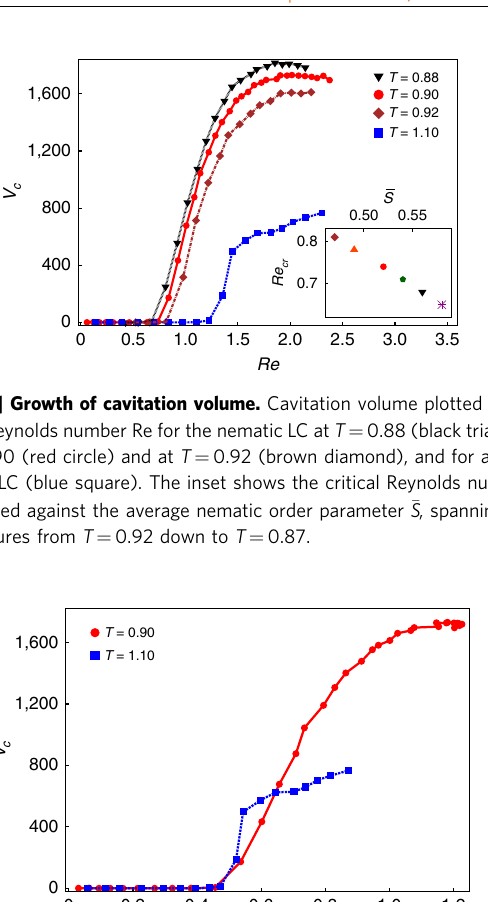
Figure 3g–i maps the local velocity over the mid-plane cross section ( x - y plane) of the nematofluidic system. At small flow rates, Er C 65, the local velocity is rather low, as indicated by the random orientations of the arrows representing the flow direction (Fig. 3g). At the onset of cavitation, Er C 897, a net flow is clearly present (Fig. 3h). The local velocity in the constriction is considerably higher than that in front of and behind the cylindrical pillar. The relative velocity difference becomes stronger at still higher flows. Figure 3i presents the velocity map at Er C 1,374 in the vicinity of the obstacle and the cavitation phase, the local convective velocity was set to zero in the cavitation area for calculating the resulting velocity map.